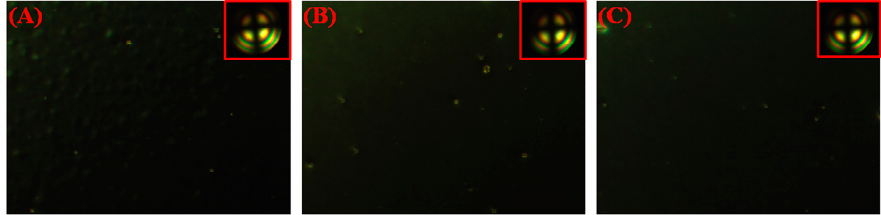
Figure 6. POM microphotographs of LC cells with 2 wt % DA monomers ( A ), 1 wt % DA monomers ( B ), and 0.5 wt % DA monomers ( C ) after UV irradiation and thermal annealing at 120 °C for 12 h.